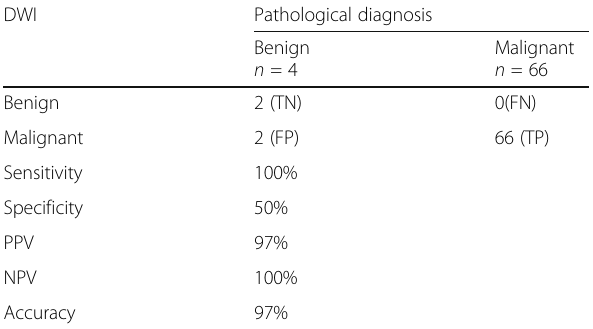
Table 3 The diagnostic performance of DWI in diagnosis of cervical carcinoma